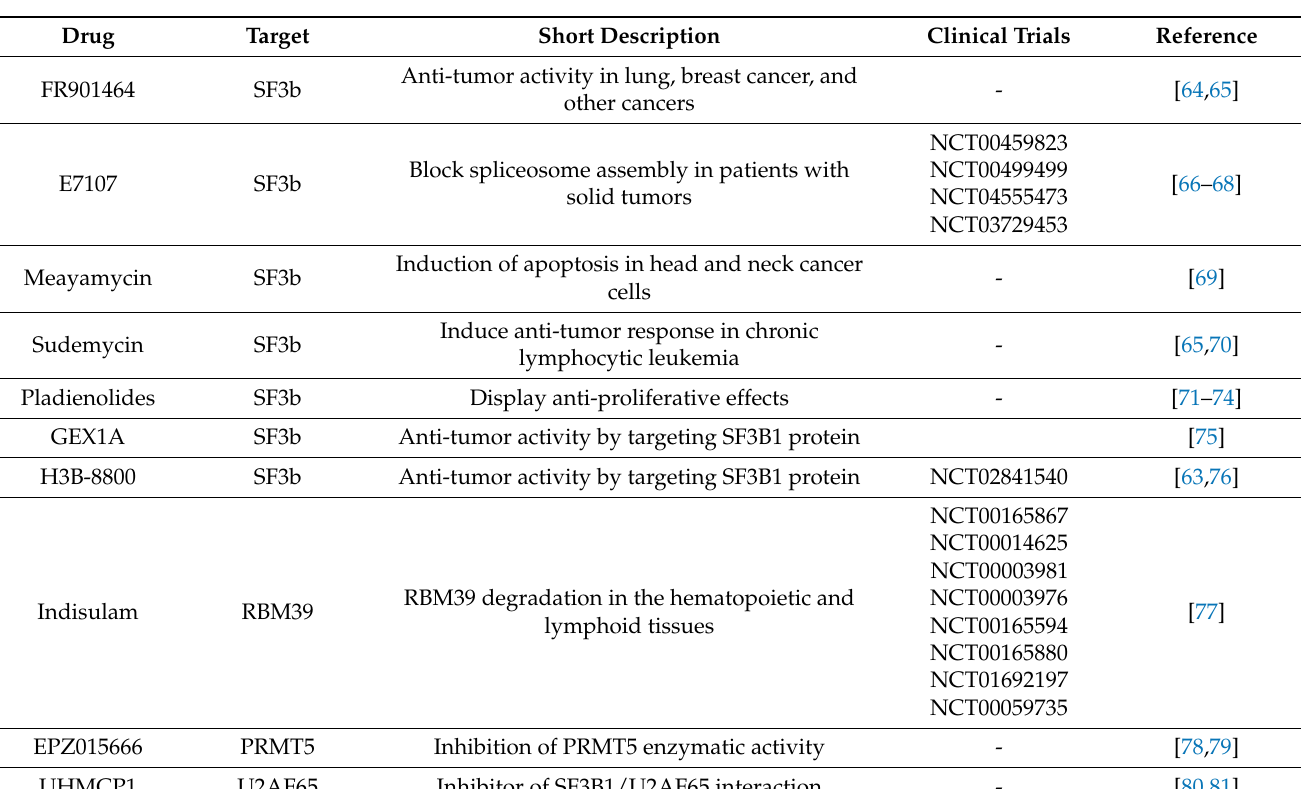
Table 1. Small molecules inhibiting RNA splicing in